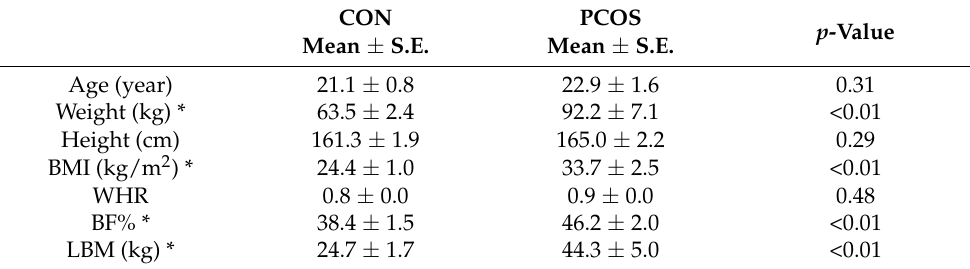
Table 2. Participant